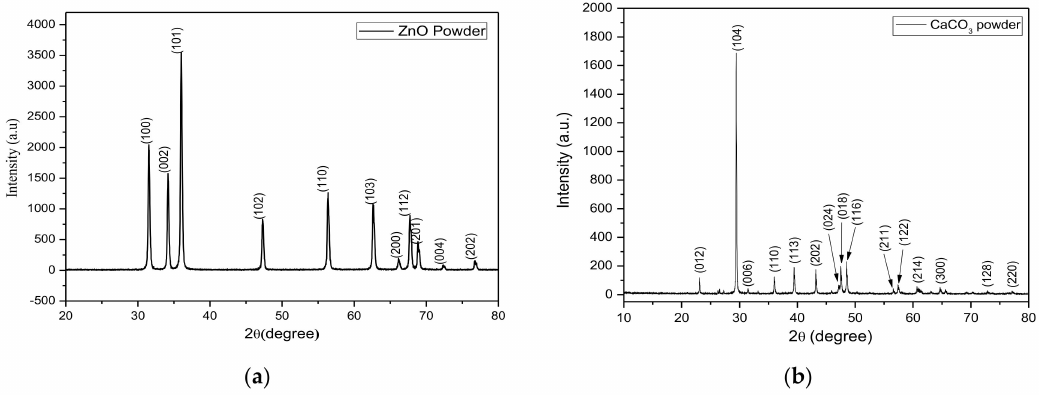
Figure 8. XRD spectrum of the ( a ) ZnO and ( b ) CaCO 3